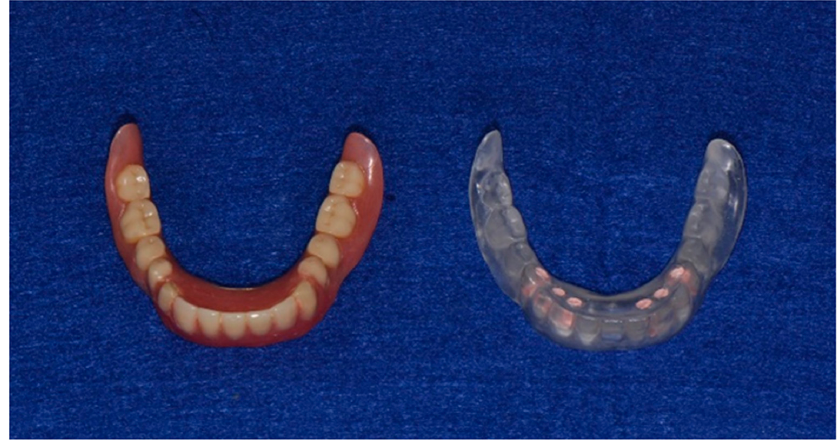
Figure 2. Wearing denture ( Left ) and diagnostic denture embedded guttapercha points in the 432 ┬ 234 (34,33,32,42,43,44) regions ( Right ).